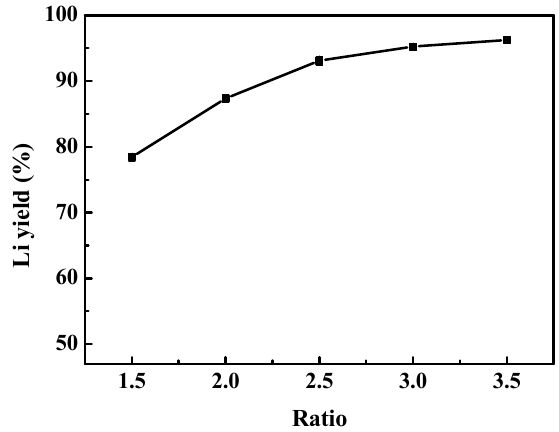
Figure 8. Effect of liquid-solid mass ratio on the extraction of lithium.